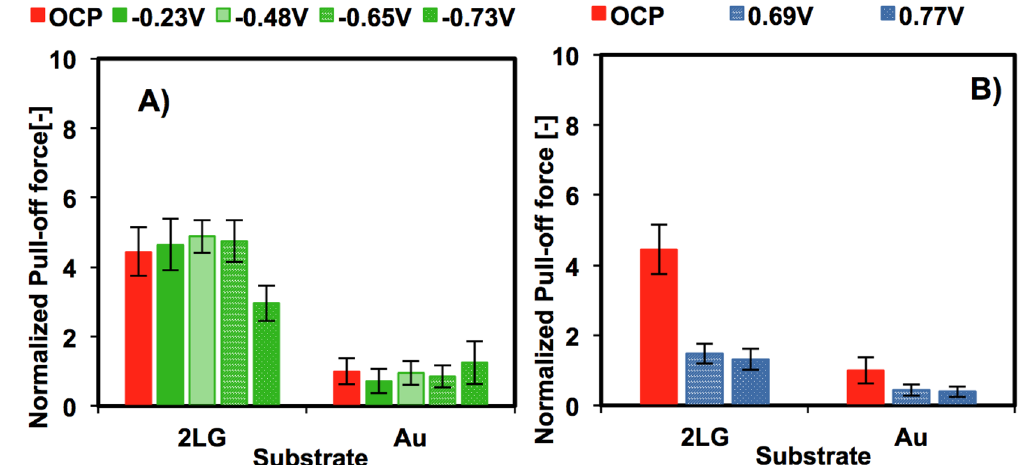
Figure 3. Pull-off force between the silicon tip and either bilayer graphene (2LG) or the gold substrate normalized by the pull-off force on gold at OCP (~0.7 ± 0.3 nN): ( A ) OCP and negative potentials ( ∆ U < 0); ( B ) OCP and positive potentials ( ∆ U >